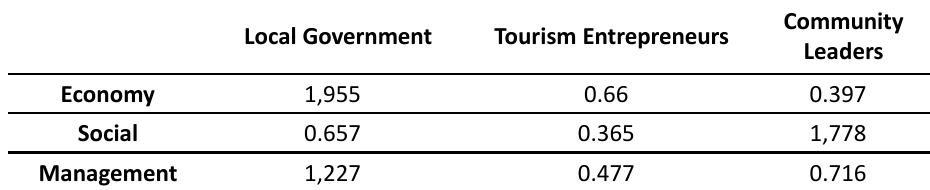
Table 9: Results of The Policy and Alternative Priorities